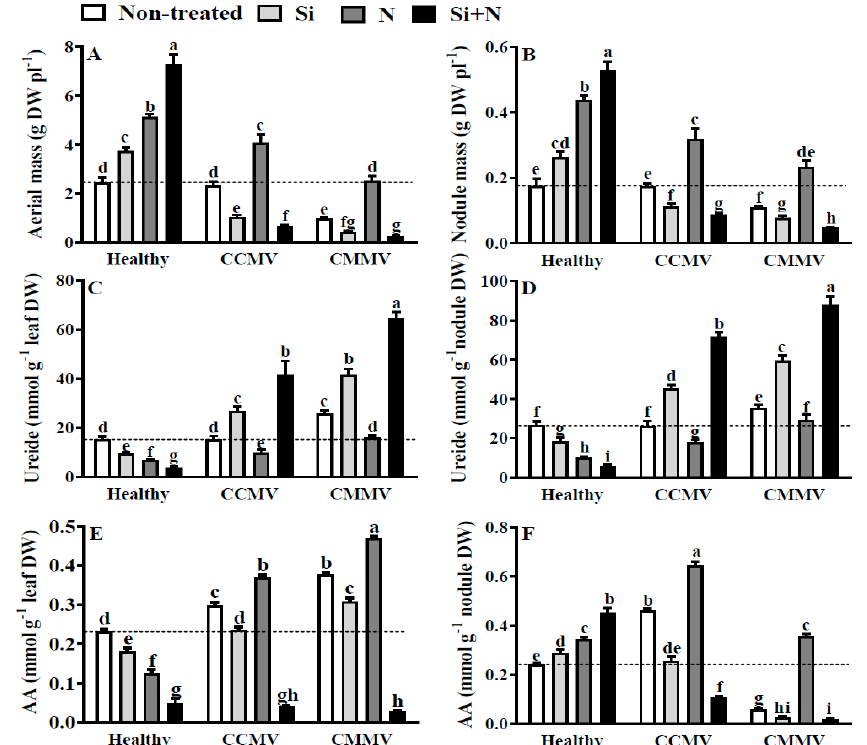
Figure 1. Effects of 2 mM silicic acid (Si), 10 mM KNO 3 (N) and the combination of Si + N on the aerial mass ( A ), nodule mass ( B ), ureide content in the leaves ( C ) and nodules ( D ), and amino acids (AA) content in the leaves ( E ) and nodules ( F ) of healthy and Cowpea chlorotic mottle virus (CCMV) or Cowpea mild mottle virus (CMMV)-infected 30-days old cowpea ( V. unguiculata ). Dotted line serves as reference to value of healthy non-treated control. Means of six replicates (±SE) in bars labeled with the same letter(s) are not significantly different (LSD, p < 0.05).